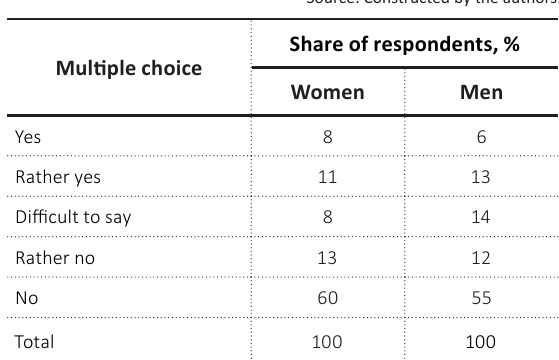
Table 10. Respondents’ answers to the question “Do you think men should have the privilege of obtaining top